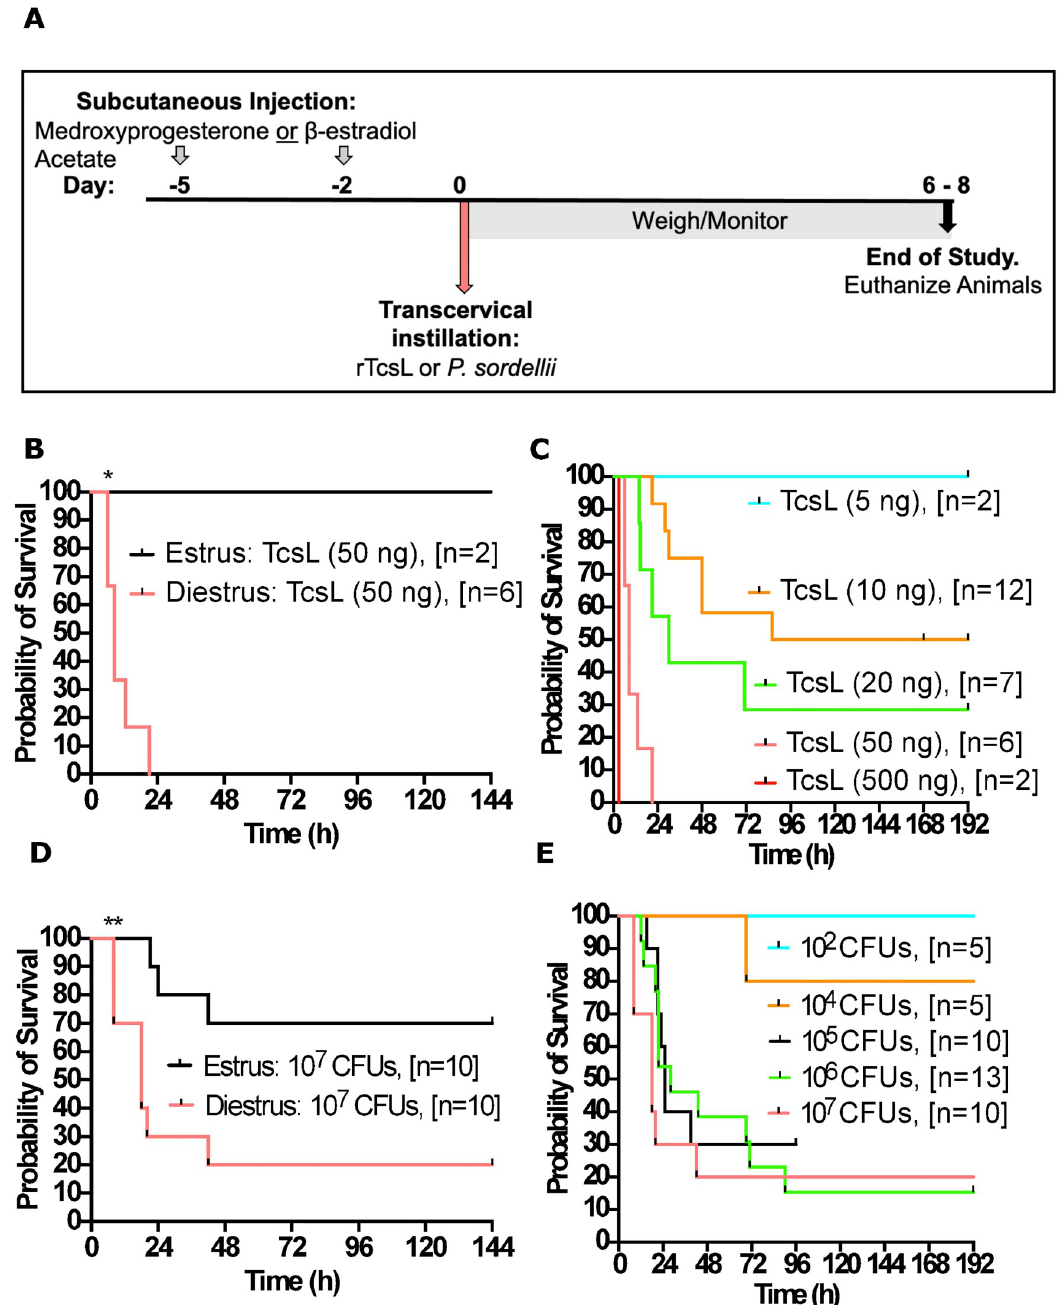
Fig 4. Development of hormonal transcervical instillation method of recombinant TcsL or vegetative P . sordellii . (A) Timeline of hormonal synchronization of murine estrous cycles following subcutaneous administration of medroxyprogesterone acetate (Day -5) to induce diestrus or beta-estradiol (Day -2) to induce estrus. Transcervical Instillation of rTcsL or P. sordellii was performed on Day 0 and animals were weighed/monitored for six to eight days. (B) Survival curve of mice subcutaneously injected with medroxyprogesterone acetate or beta-estradiol followed by transcervical intoxication with 50ng TcsL. (C) Survival curve of mice subcutaneously injected with medroxyprogesterone acetate followed by transcervical intoxication with 5, 10, 20, 50, 500ng TcsL. (D) Survival curve of mice subcutaneously injected with medroxyprogesterone acetate or beta-estradiol followed by transcervical infection with 10 7 CFUs vegetative P . sordellii ATCC9714. (E) Survival curve of mice subcutaneously injected with medroxyprogesterone acetate followed by transcervical infection with 10 2 , 10 4 , 10 5 ,10 6 , 10 7 CFUs vegetative P . sordellii ATCC9714. Log-rank (Mantel-Cox) multiple comparison test was used with statistical significance set at a p value of < 0.05.